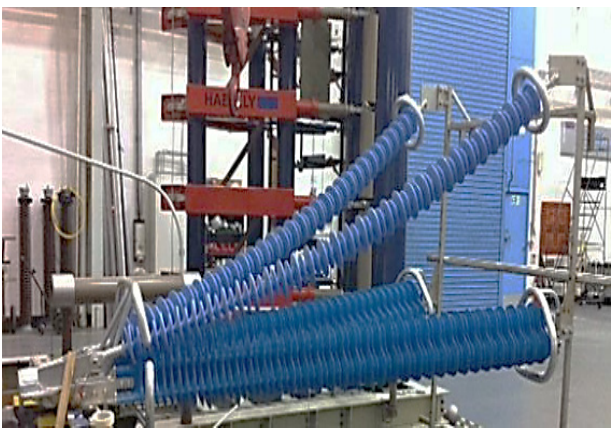
Figure 13. Full ‐ scale prototype cross ‐ arm [35]. Figure 13. Full-scale prototype cross-arm